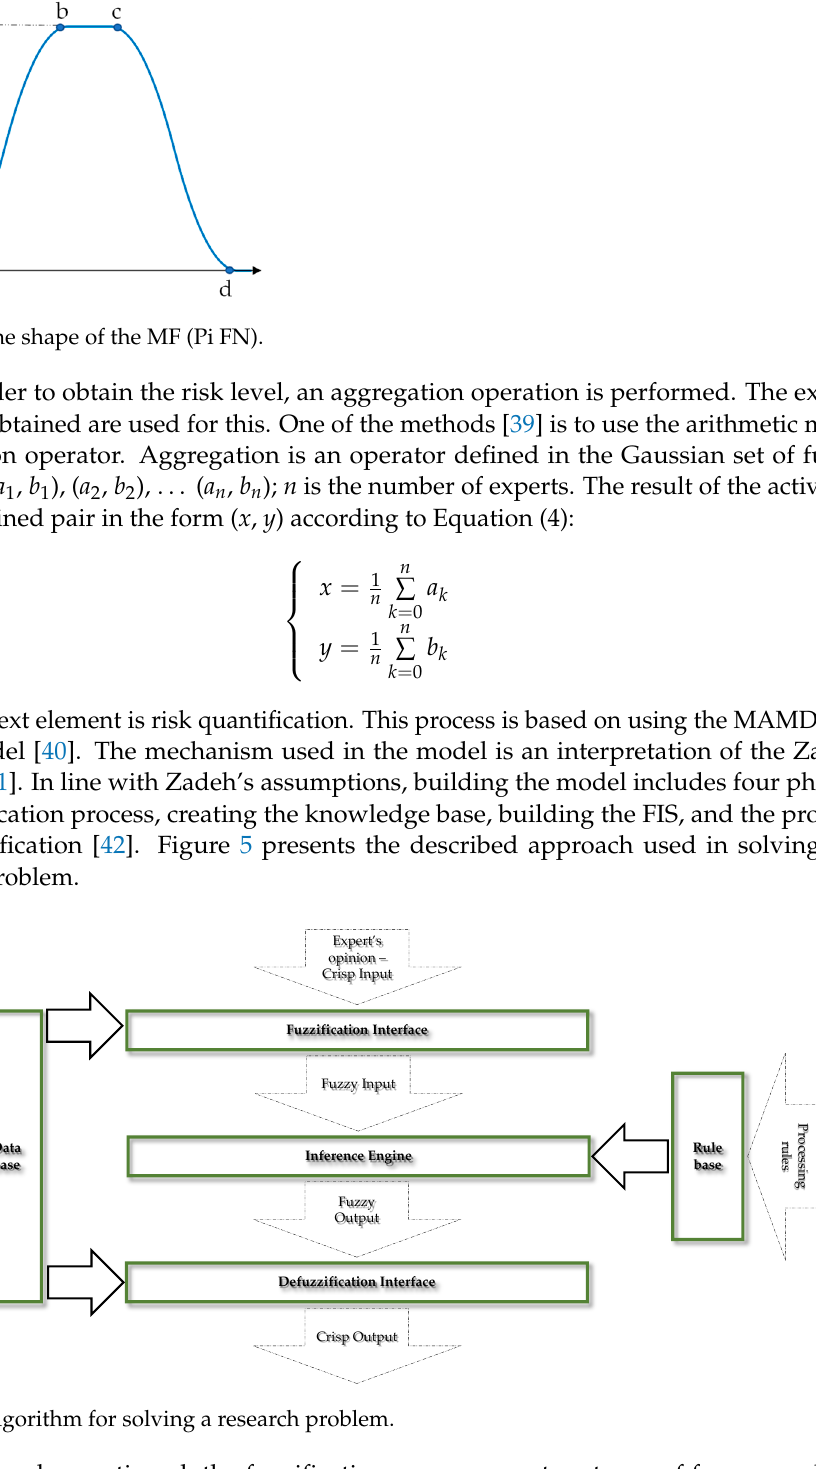
Figure 6. FIS of MAMDANI model: MIN and MAX operator.